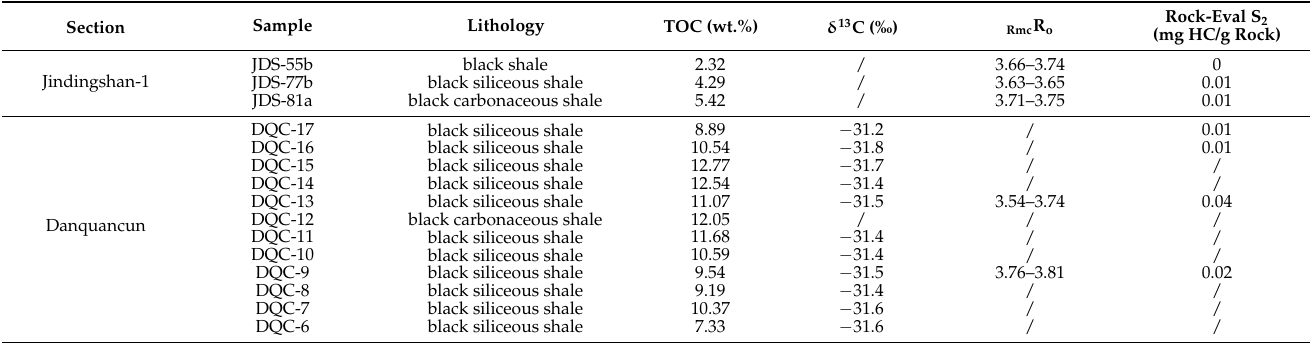
Table 1. Lithology and petrogeochemical characteristics of the Niutitang shale in the Jindingshan-1 (JDS-1) well and Danquancun (DQC)